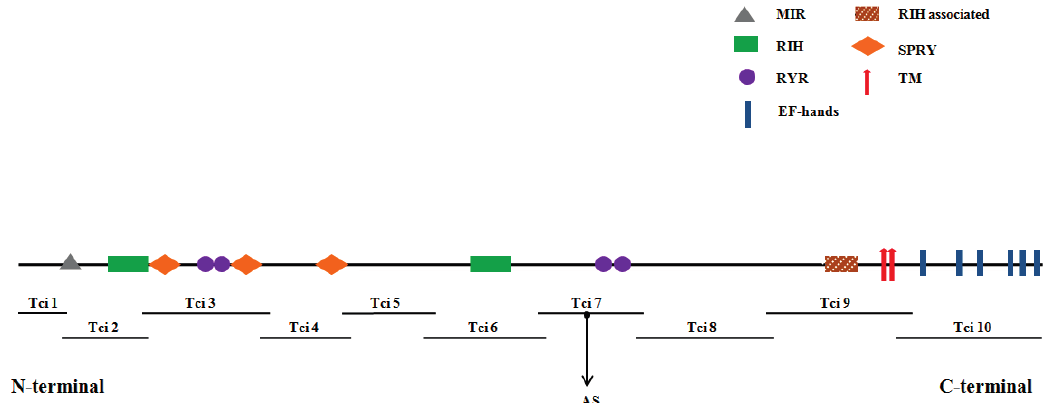
Figure 1. Analysis of conserved structural domains in ryanodine receptor (RyR) and the strategy used to clone RyR in Toxoptera citricida (TciRyR). All fragments labeled “Tci” were used to assemble TciRyR. Lines show the length and relative location of